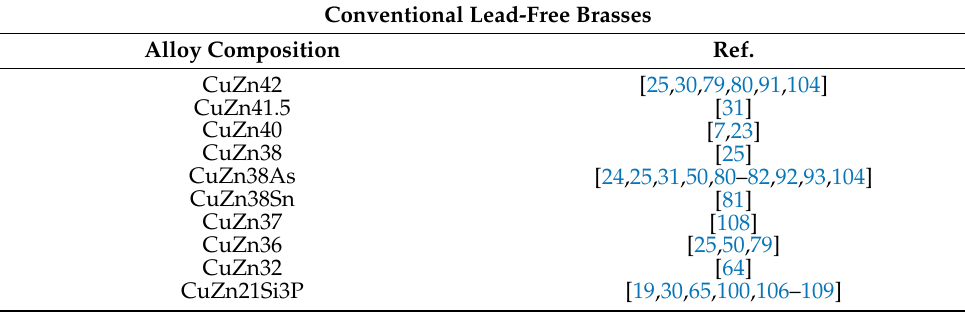
Table A2. Conventional lead-free (Pb-free) brass compositions.